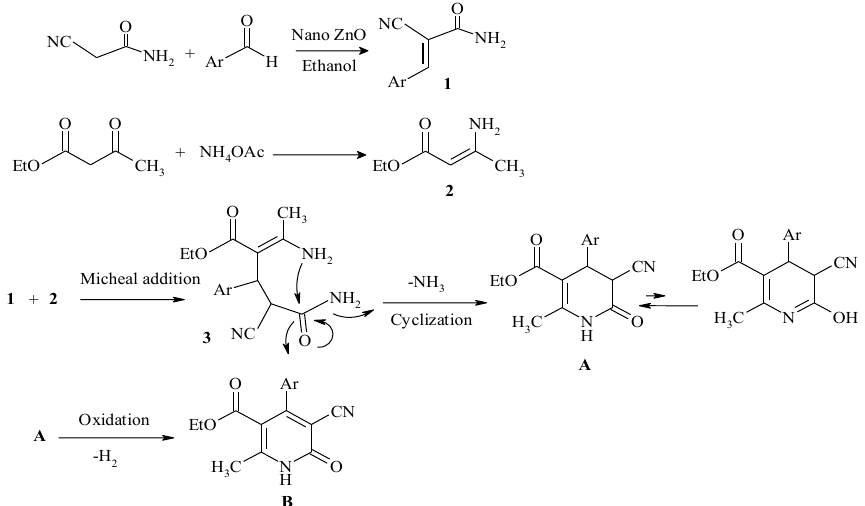
Figure 2. Suggested mechanism for formation of compound A and